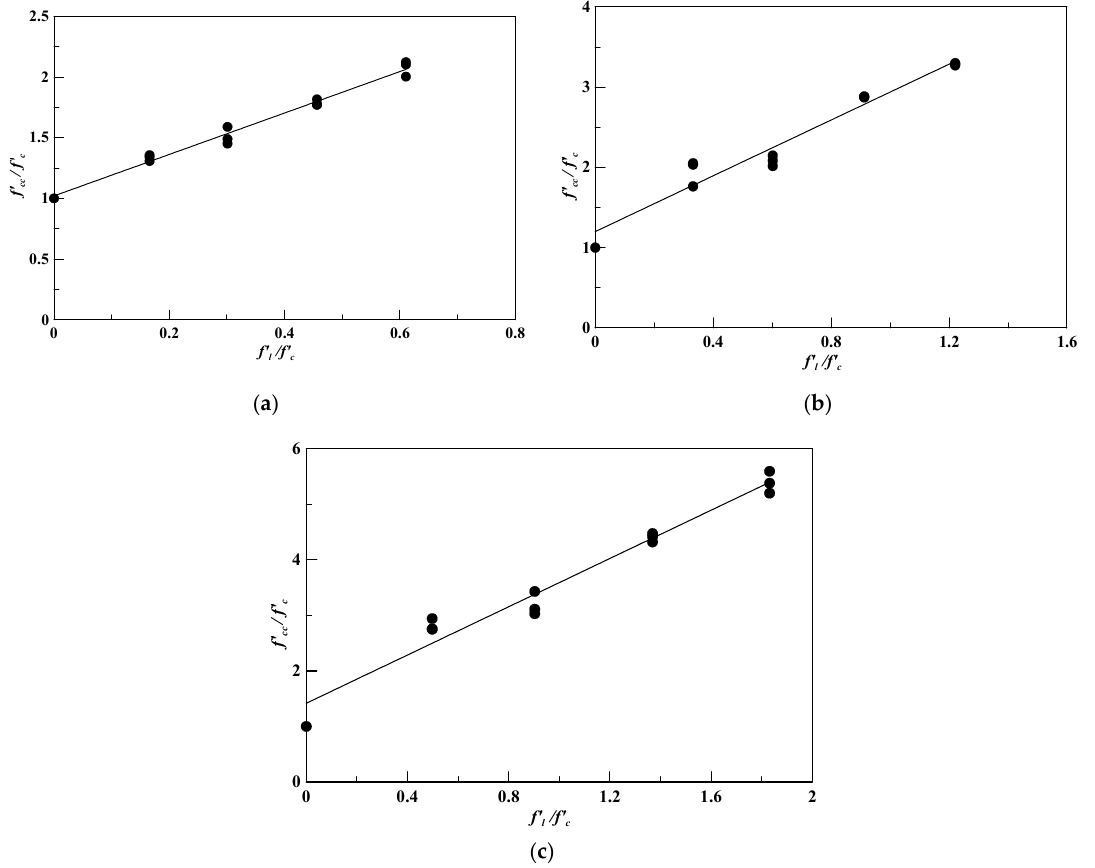
Figure 6. The regression analysis results of the specimens confined with different layers of CFRP with the friction angle: ( a ) one-layer CFRP ( ϕ = 15.2°) ; ( b ) two-layer CFRP ( ϕ = 15.6°) ; ( c ) three-layer CFRP ( ϕ = 21.7°).